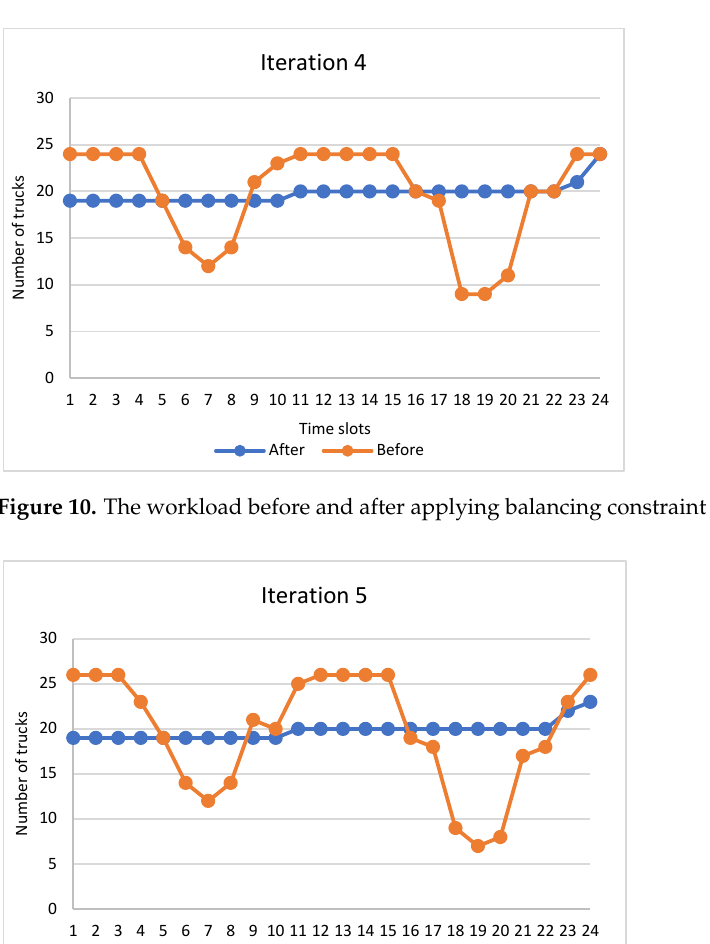
Figure 9. The workload before and after using balancing constraint on iteration 3.